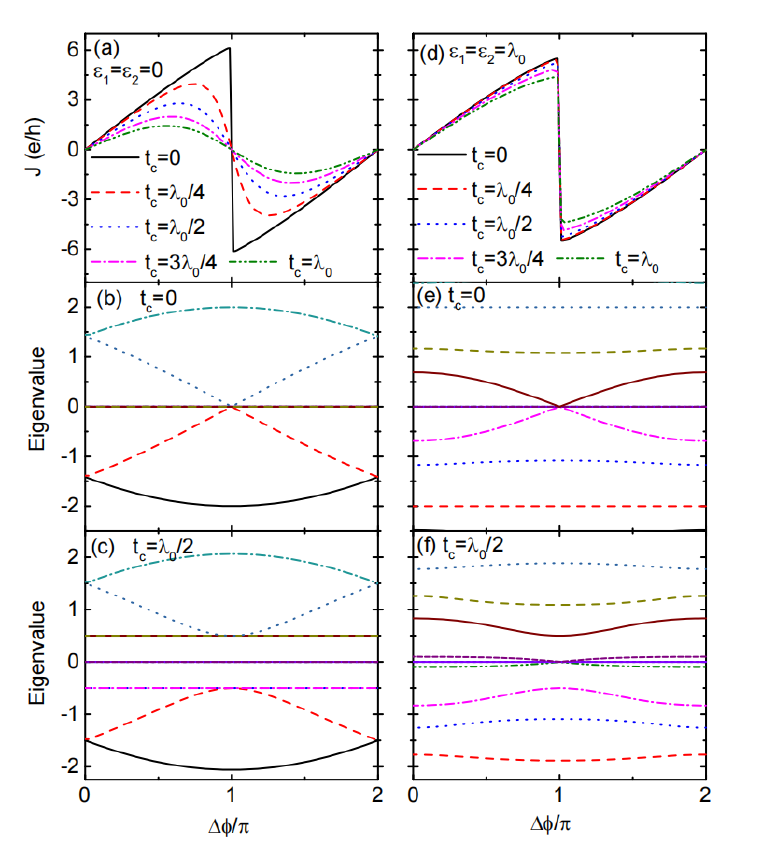
Figure 2. (Color online) Josephson current in ( a , d ) and the associated in-gap energy diagram in ( b , c , e , f ) versus the phase difference between the left and right Majorana nanowires for different values of inter-dot coupling strength t c and QDs’ levels. Other parameters are θ = 0, δ M = 0, and B x =